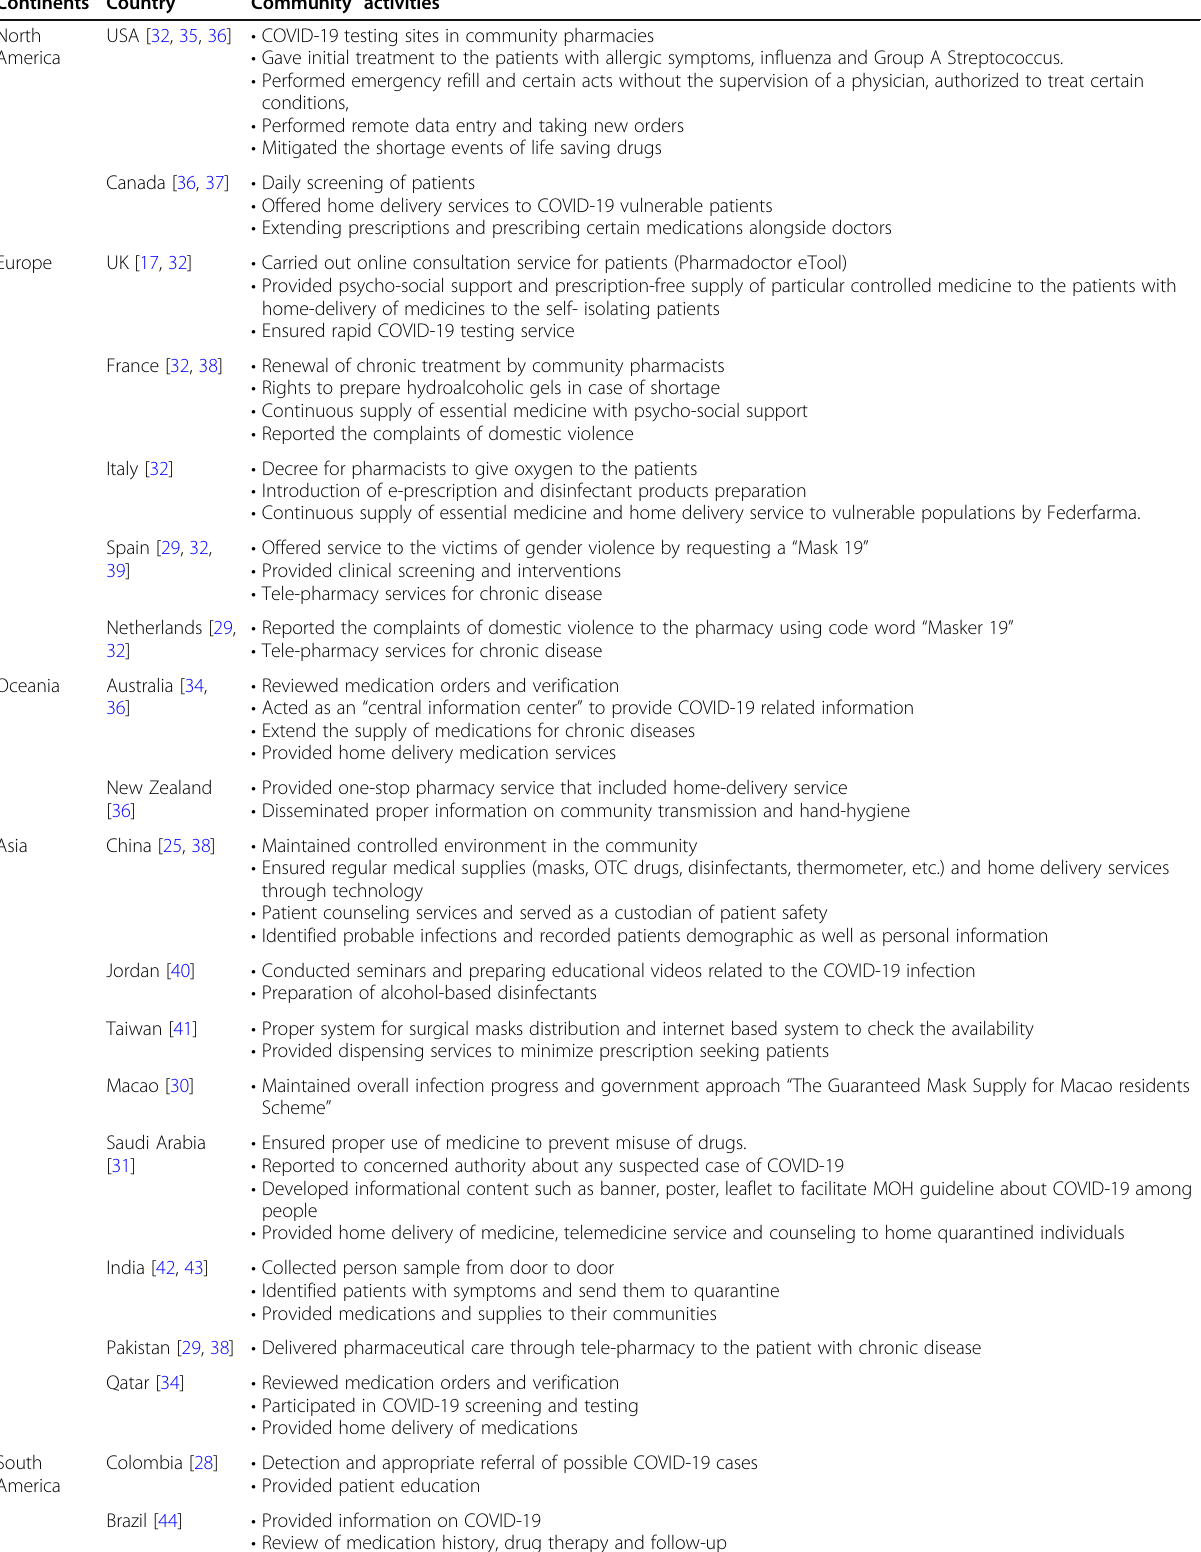
Table 1 Services provided by community pharmacists in tackling COVID-19 health crisis Continents Country Community